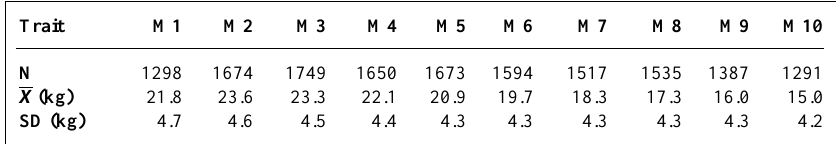
Table II - Observed means ( X ), number of observations (N) and standard deviations (SD) of test day milk yields (M1 to M10) of first lactation Holstein cows. Trait